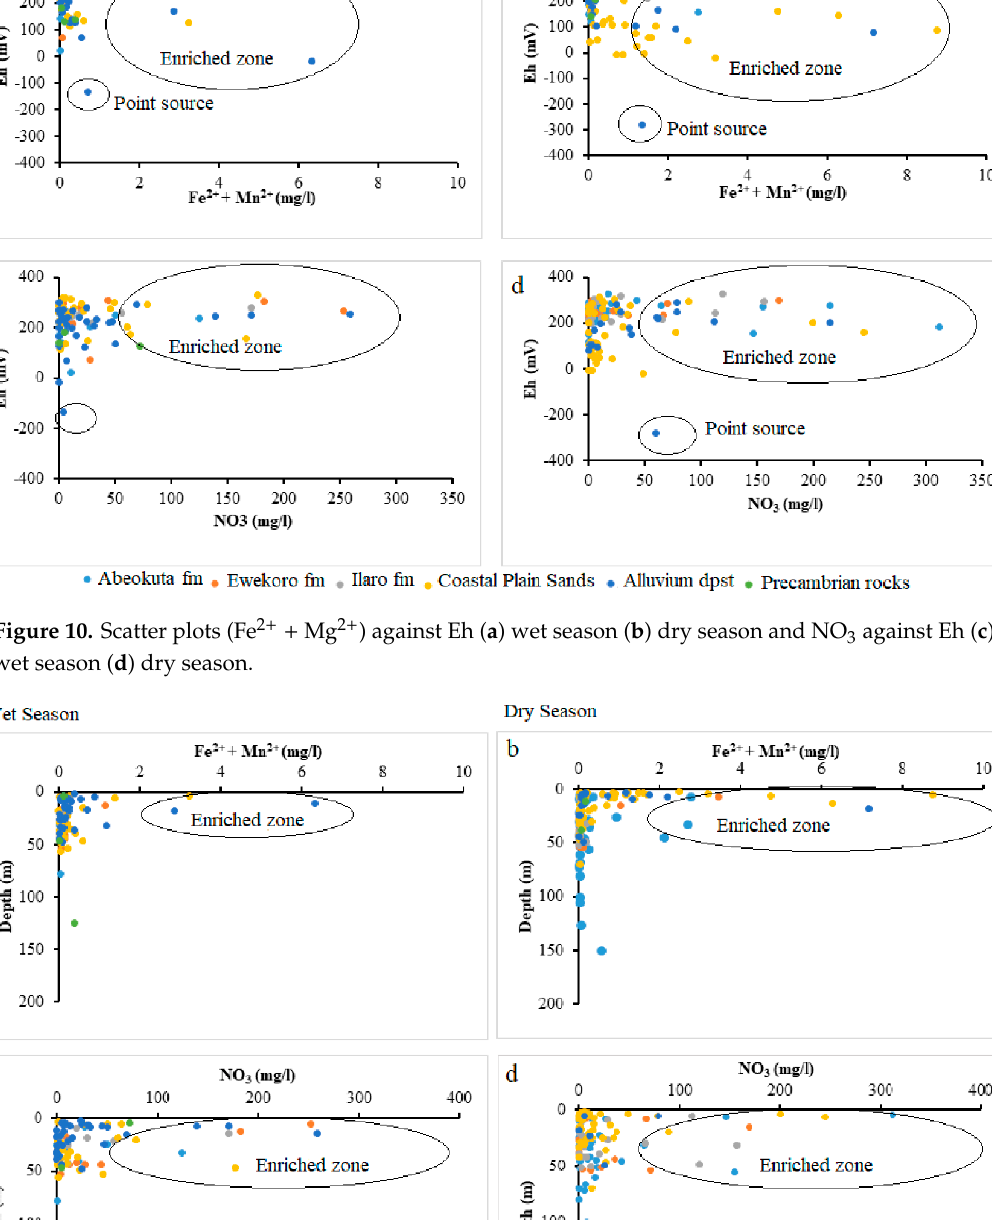
Figure 9. Scatter plots NO 3 against Fe 2+ ( a ) wet season ( b ) dry season and Fe 2+ + Mn 2+ against Cl − ( c ) wet season ( d ) dry season.